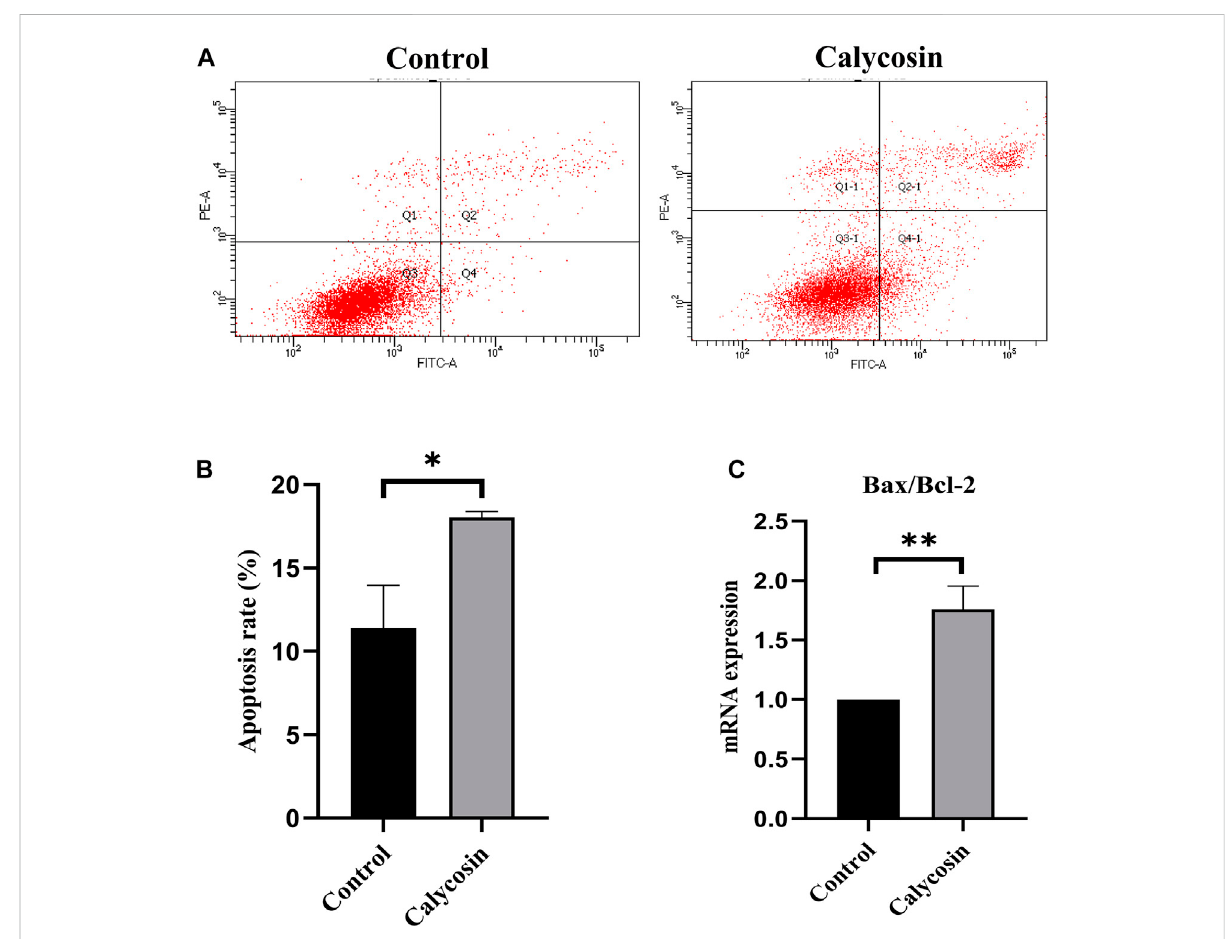
apoptosis rate of BCPAP cells treated with calycosin increased (Figure 4B) compared to control group. The relative expression of Bax/Bcl-2 in the calycosin group was higher than in untreated cells (Figure 4C). These results suggested that the calycosin treatment promoted the apoptosis of B-CPAP